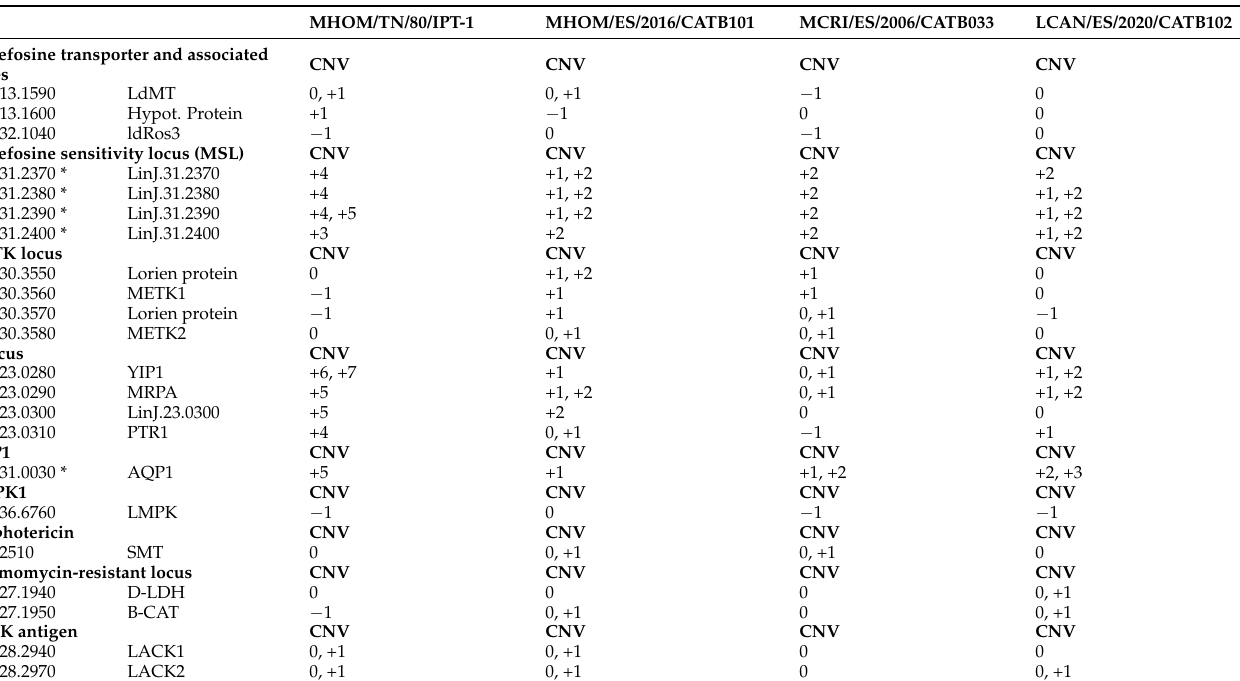
Table 3. Detection of CNV in 22 genes suitable as potential pharmacoresistance and pathogenicity biomarkers in L infantum . Variation in its local copy number for each sample, ranging between − 1 and +7 gene copies compared to the diploid dotation (0). * Tetrasomy in chromosome 31 must be